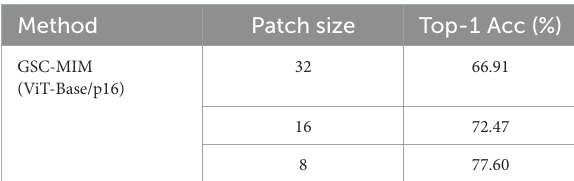
TABLE 3 Experimental results comparison with patch size as